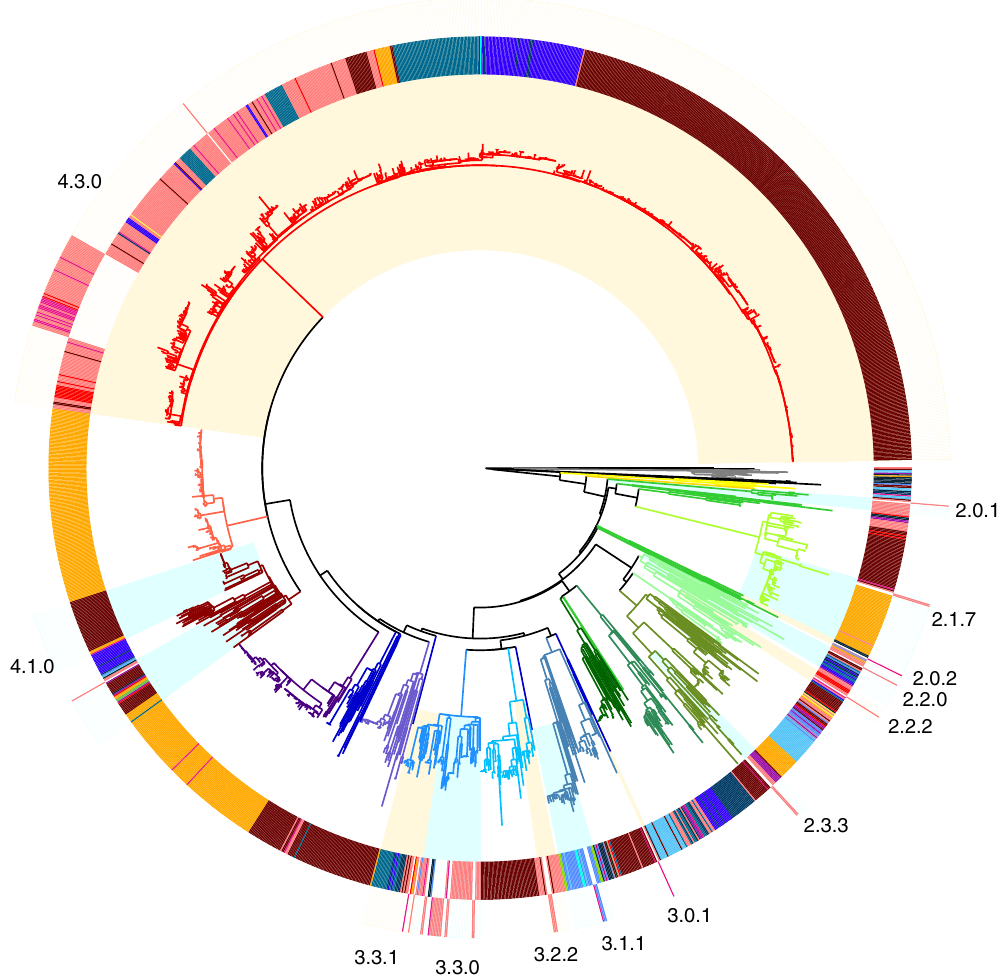
Figure 3 | Phylogeny of 99 travel-associated S . Typhi in comparison with the global genomic framework containing 1,831 isolates. Whole-genome SNP tree is shown in the centre and branches are coloured by clade. Rings indicate region of origin: inner ring, global collection; outer ring, travel-associated isolates. Subclades that contain travel-associated isolates are highlighted within the tree (shaded in alternating colours) and labelled around the outside; intrasubclade phylogenies are provided in Supplementary Fig.